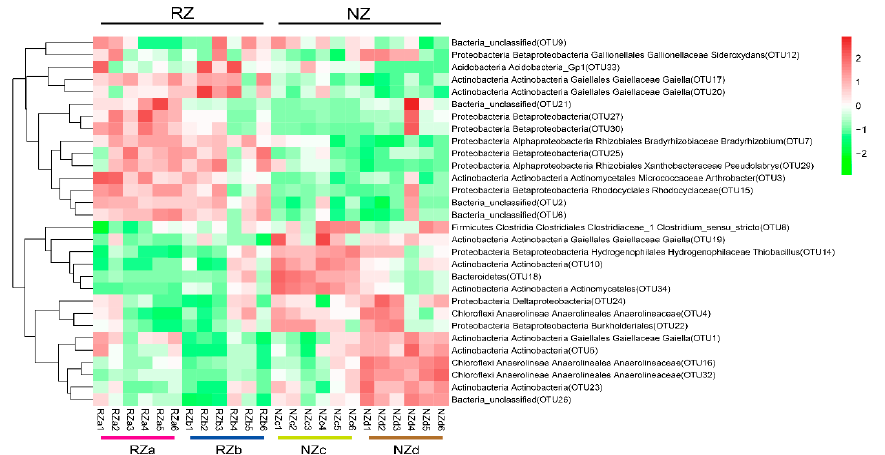
Figure 2. Heat map depicting the relative abundance of dominant OTUs (average relative abundance > 0.2%) in the di ff erent sampling sites. The relative abundance dates were normalization and clusters were generated using Euclidean distance in R. Abbreviations: P. australis zone (RZ); non- P. australis zone (NZ); supralittoral zone with P. australis (RZa); eulittoral zone with P. australis (RZb); eulittoral zone without P. australis (NZc); infralittoral zone without P. australis